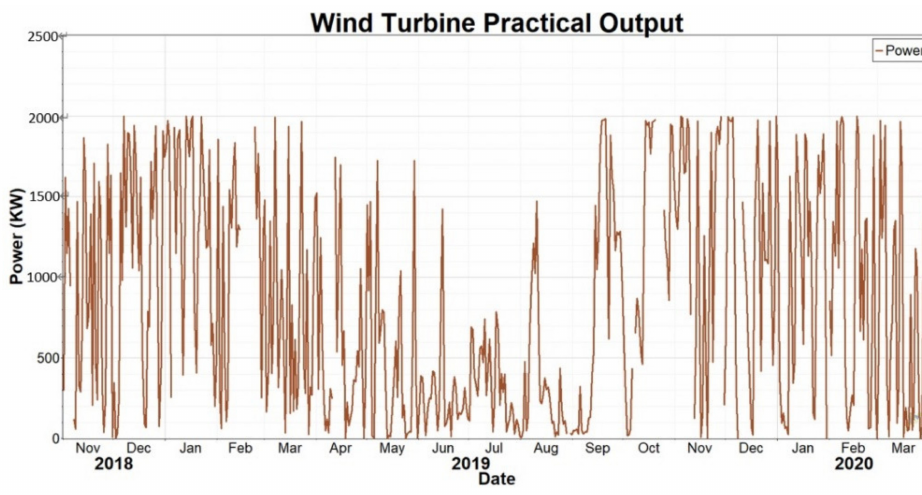
Figure 14. Wind-turbine practical-output trend